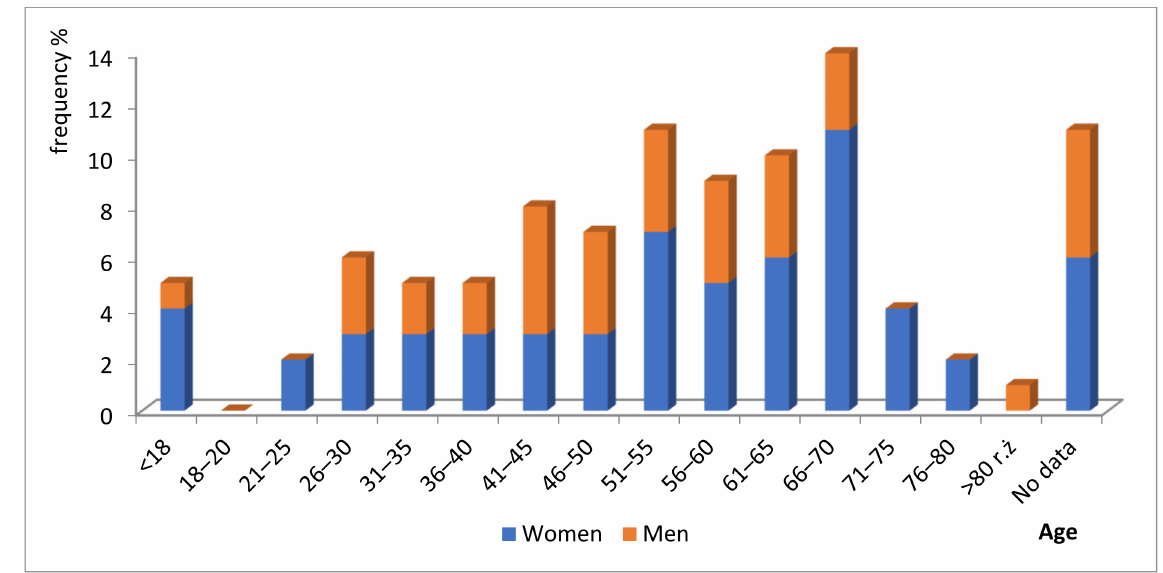
Figure 2. Age categories of patients divided by sex